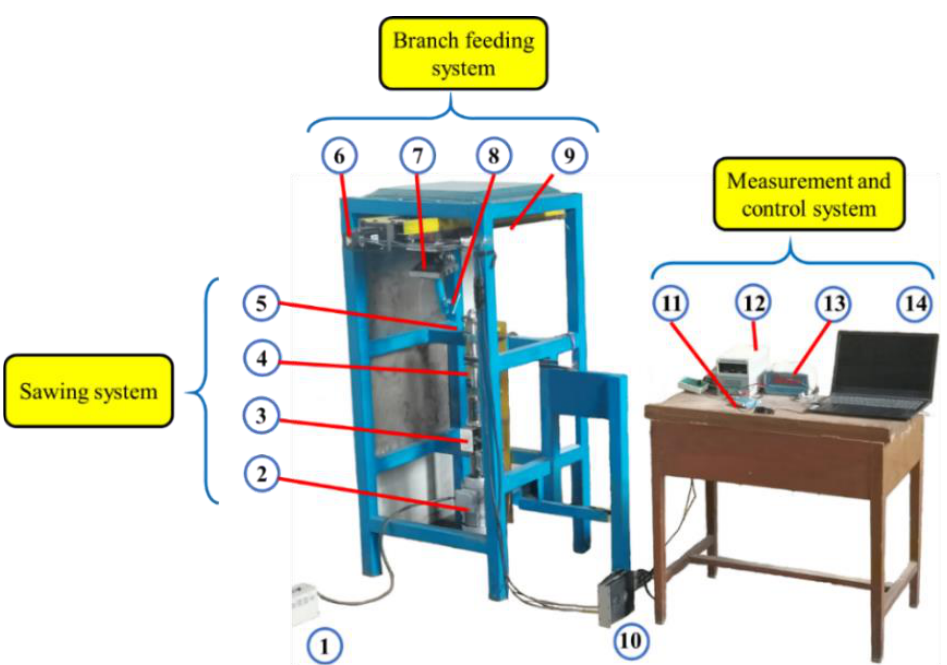
Figure 1. Schematic diagram of the structure of the sawing test bench . ( 1. Variable-frequency drive 2. AC motor 3. Torque sensor 4. Rotary cutting shafts 5. Circular saw 6. Servo motor 7. Angle adjustment fixture 8. Branch holder 9. Ball screw mechanism 10. Servo drives 11. Data acquisition card 12. Stabilized voltage supply 13. Instrument display 14. Laptop ).